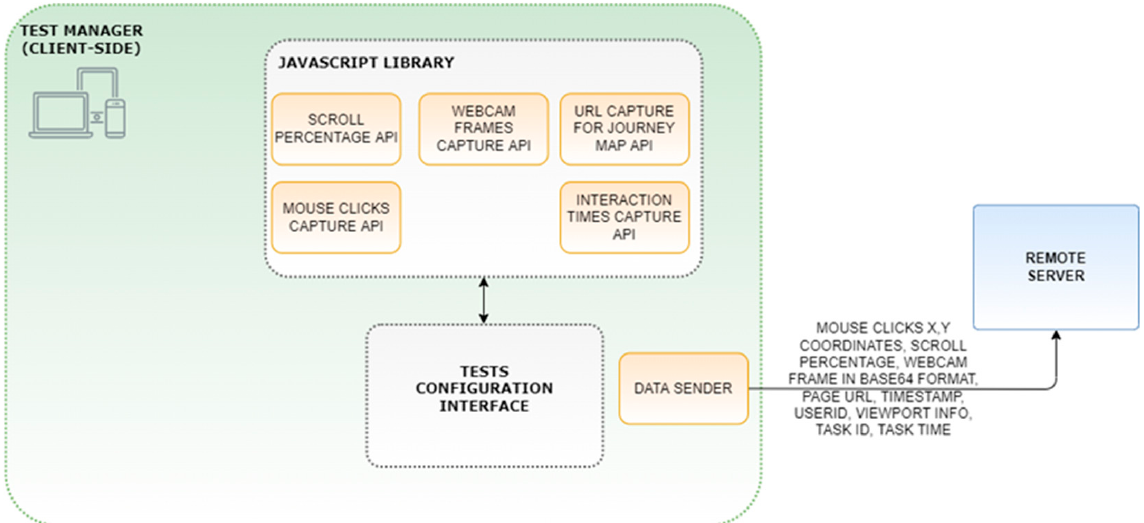
Figure 3. The proposed platform: Test Manager architecture.